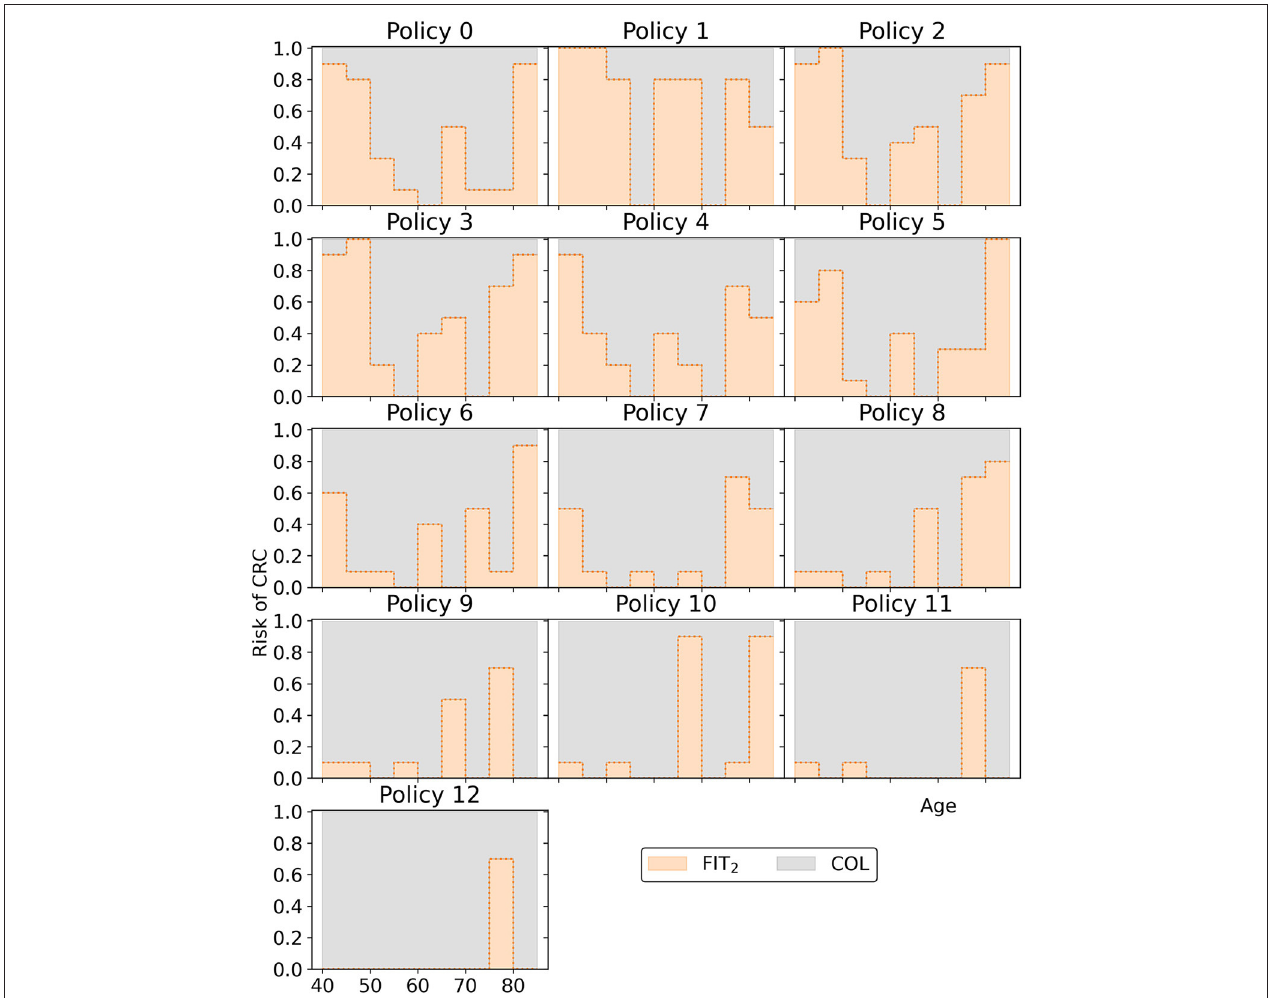
FIGURE 15 | The policies that form the minimal representation of the approximation set of Experiment 3 as shown in Figure 10 . Note that a cutoff at a perceived risk of 1.0 implies that participants with a FIT-concentration above 100 µ g/g are referred for a